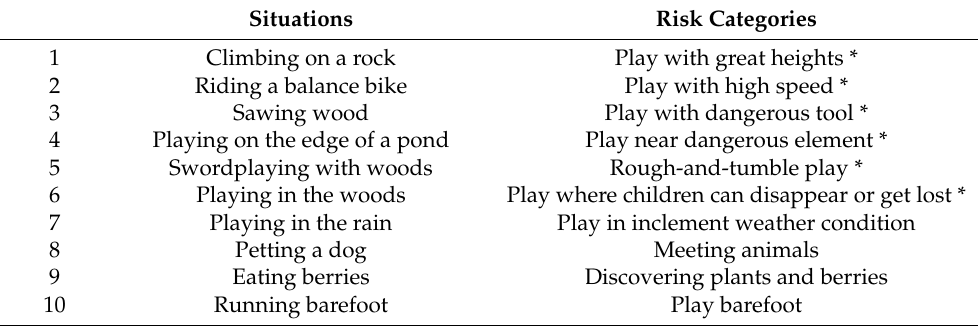
Table 1. List of situations and associated risk categories in the photo-based